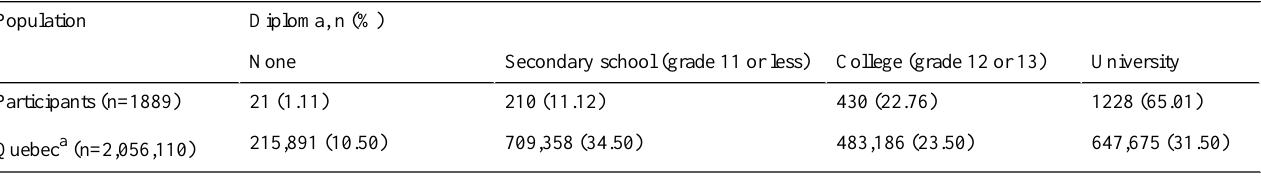
Table 1. Level of education: participants of the quantitative component versus Quebec 25- to 44-year-old population. Diploma, n (%)Population